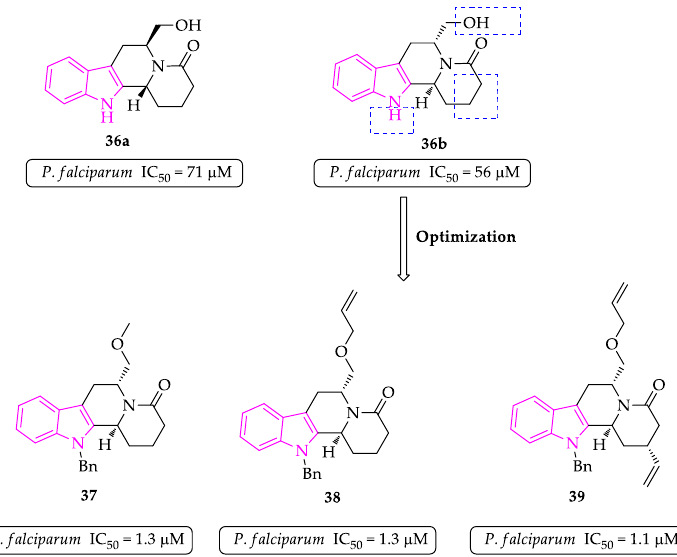
Figure 5. Optimization of the indoloisoquinoline scaffold.